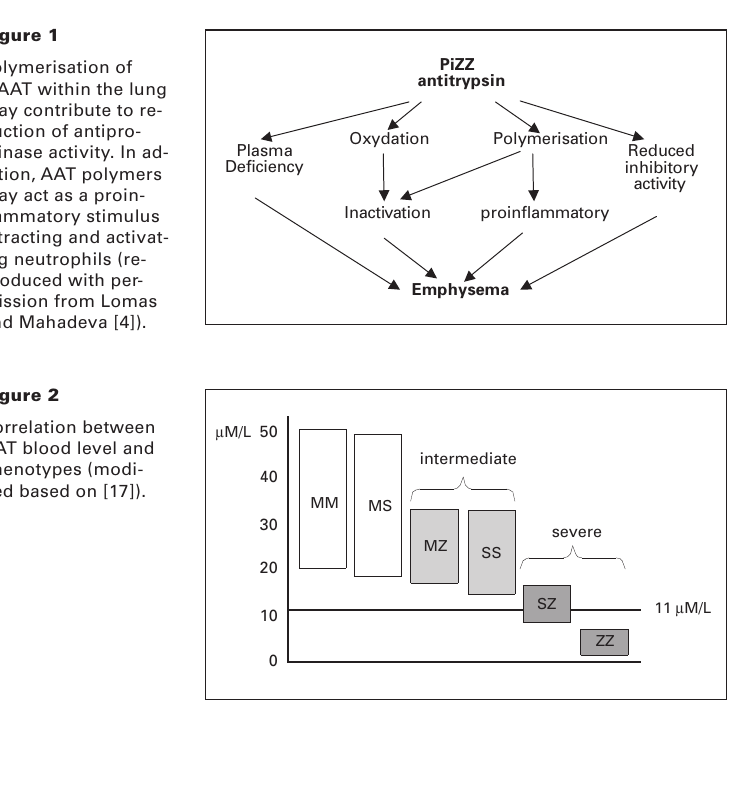
Polymerisation of Z AAT within the lung may contribute to re- duction of antipro- teinase activity. In ad- dition, AAT polymers may act as a proin- flammatory stimulus attracting and activat- ing neutrophils (re- produced with per- mission from Lomas and Mahadeva [4]).